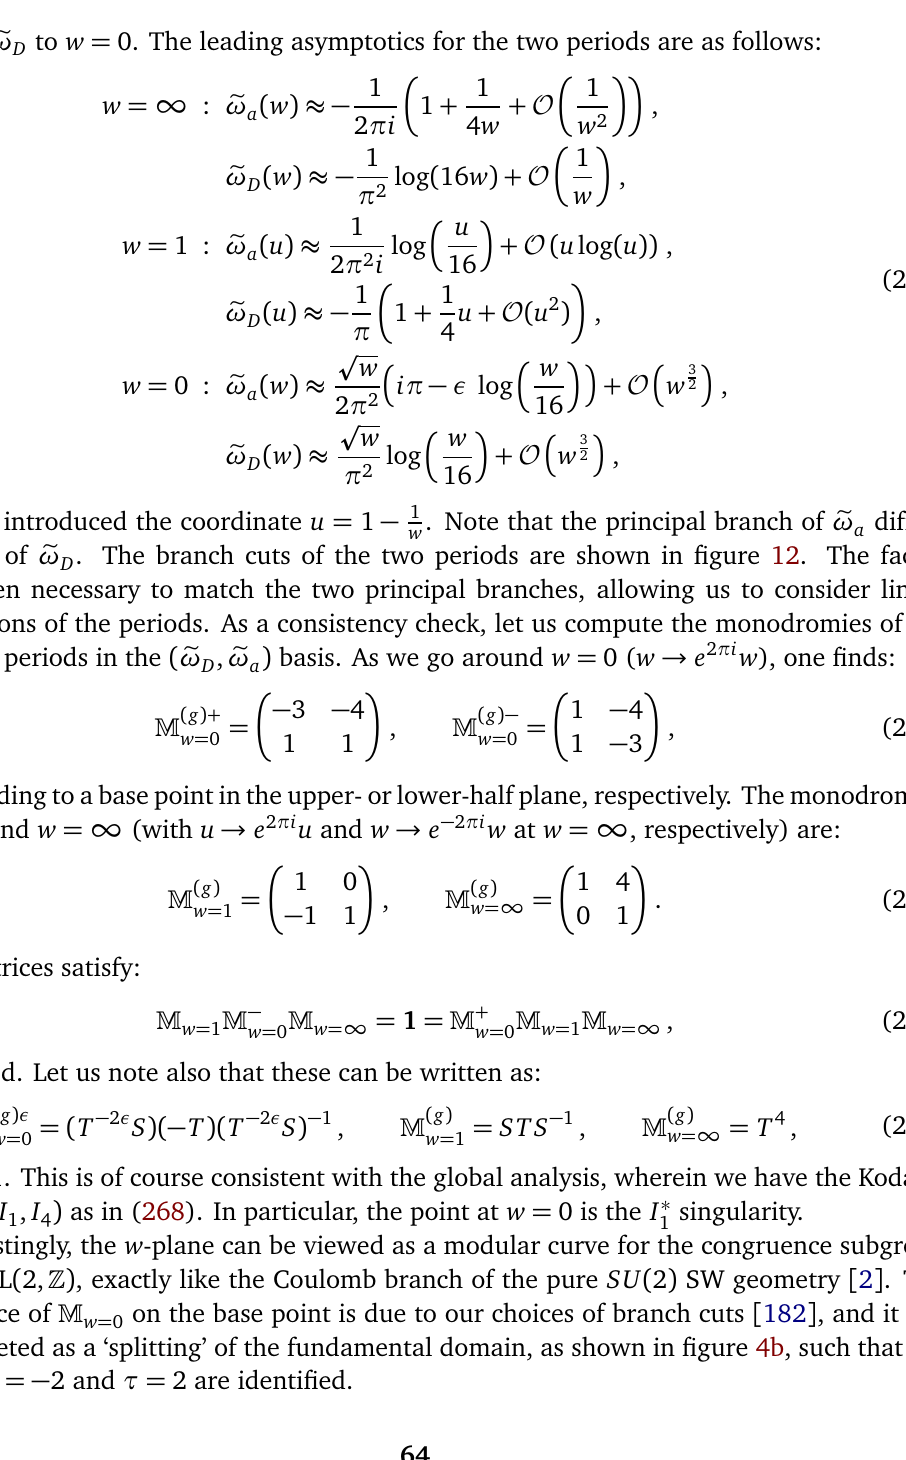
ω ω and , (cid:101) (cid:101) D a